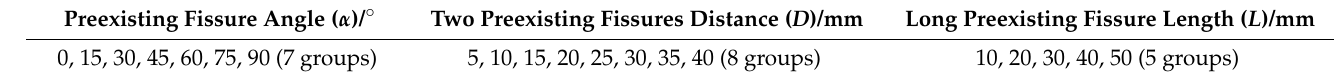
Table 1. Geometric parameters of two unequal parallel preexisting fissures.